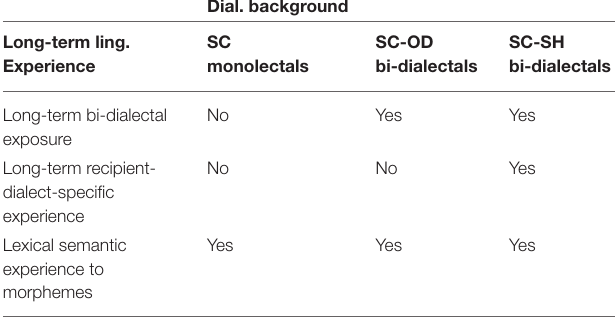
TABLE 1 | Different types of long-term linguistic experience (header column) and their predicted influences on the effects of dialectal backgrounds (header row). Dial.